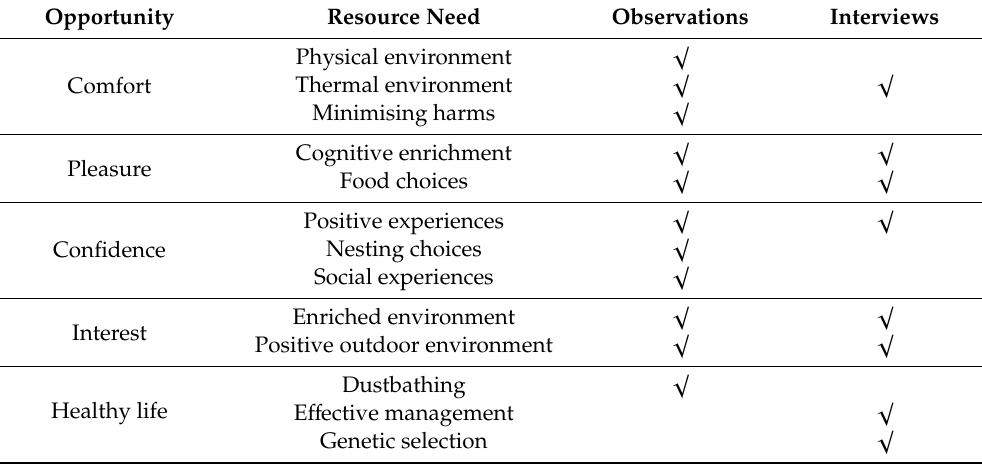
Table 1. Resource tier framework and methods of